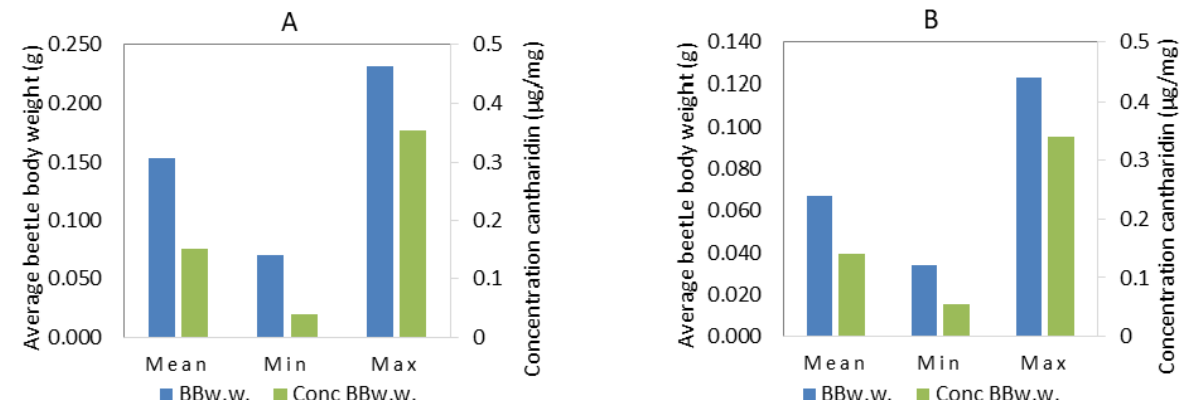
Figure 2. Graphical discriptive statistics for blister beetle wet body weight (BBw.w., blue bars) and concentration of cantharidin per Bw.w. (Conc BBw.w., green bar) in blister beetles: ( A ) M. variabilis ( n = 17) and ( B ) Epicauta rufidorsum ( n